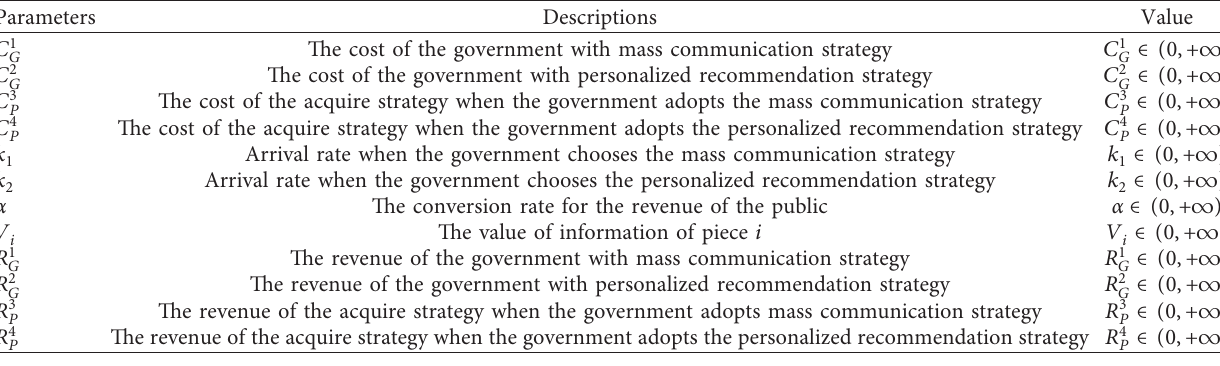
Table 3: All parameters and their descriptions.